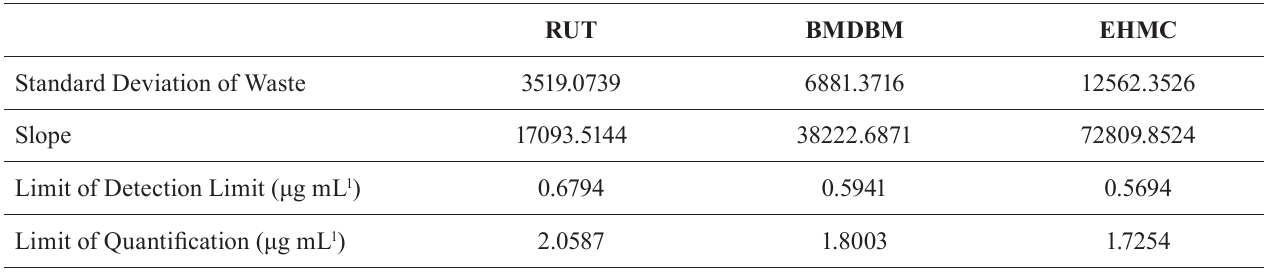
TABLE VII - LOD and LOQ values obtained for rutin, BMDBM, and